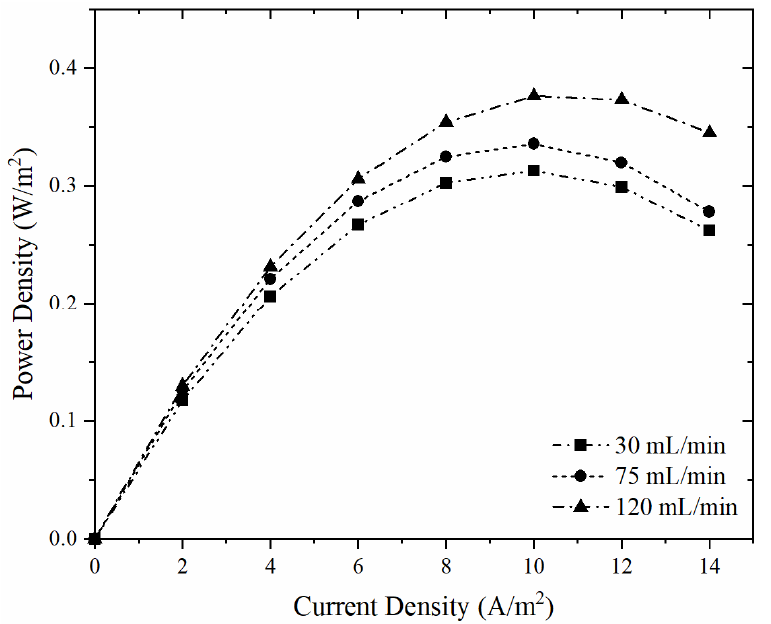
Figure 9. Power density values with ER4-BR1.07 and NEOSEPTA CMX membranes at different feed flowrates. Table 8. RED performance of the synthesized membranes.